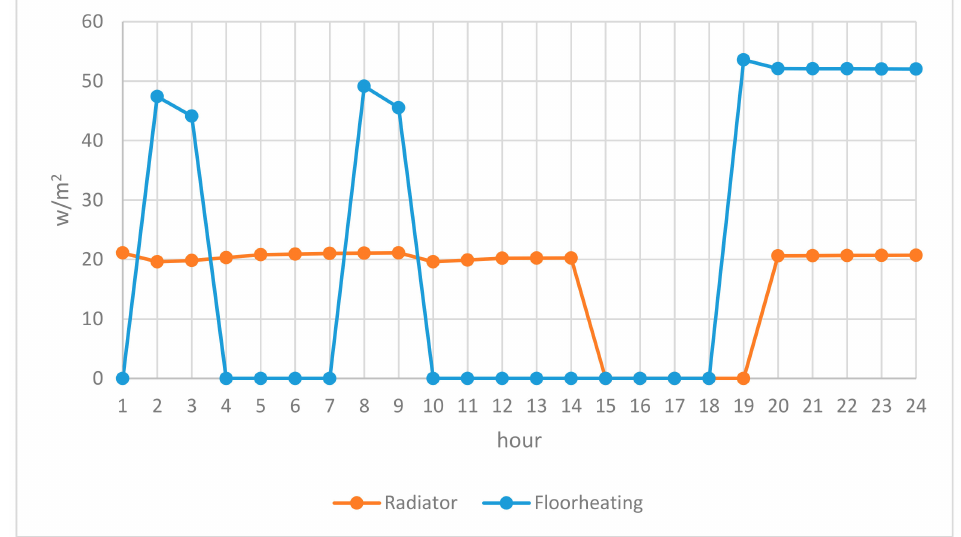
Figure 8. Supply heating demand profile for the studied passive building with radiator and floor heating systems on the design